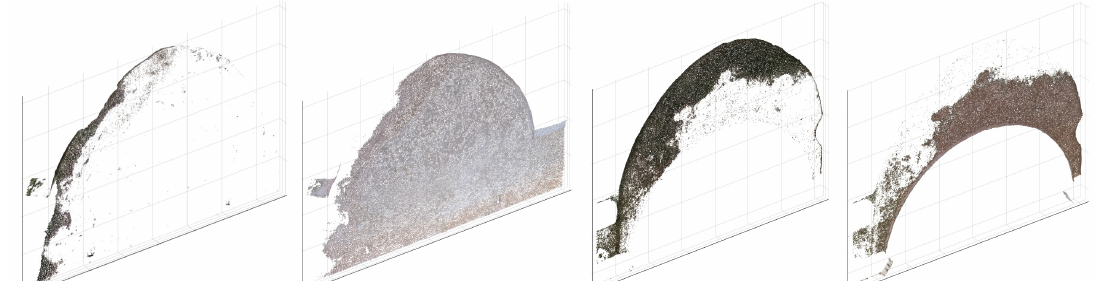
Figure 10 From left to right: biological colonization and unaltered surface of the wall on the left; biological colonization and moist area of the wall visible on the